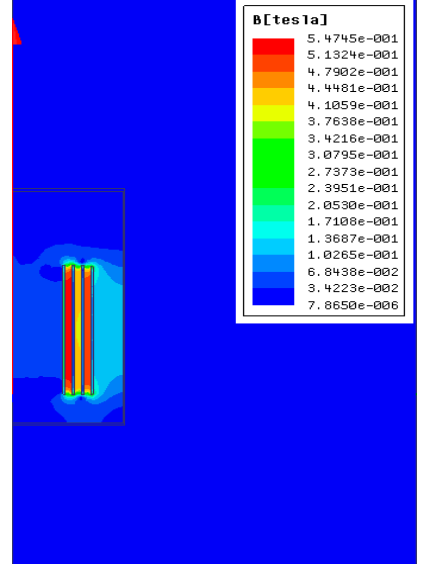
Figure 16. The magnetic field distribution of the coupling reactor.